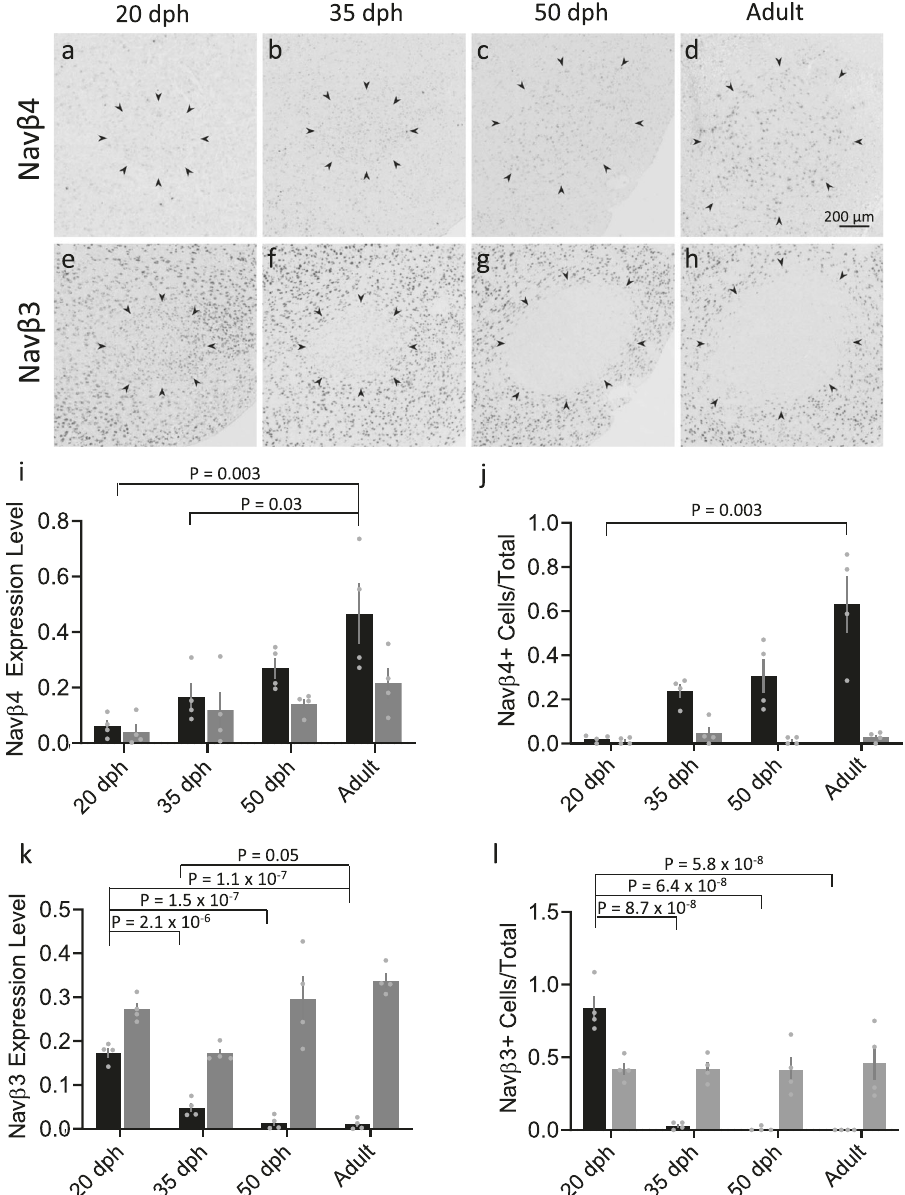
Fig. 3 Age-dependent changes in expression of Nav β 3 and Nav β 4 mRNAs in the arcopallium of male zebra fi nches. a – d Representative in situ hybridization images for Nav β 4 mRNA within RA across ages indicated by days post hatch (dph); black arrowheads indicate RA borders. e – h . Representative in situ hybridization images for Nav β 3 mRNA within RA across ages. Black arrowheads indicate RA borders. i Comparison of Nav β 4 expression levels (normalized optical density) across age groups within RA (black) and in a caudal arcopallial region of equal size outside RA (gray). Signi fi cant age differences were observed in RA (one-way ANOVA with Tukey ’ s post hoc; P = 0.005, F (3, 12) = 7.416, N = 4 males per age). Data are presented as individual data points with bars as mean values ± SEM. j Comparison of the proportions of Nav β 4-expressing cells across age groups within RA (black) and in an arcopallial region of equal size outside RA (gray). Signi fi cant age differences in RA (one-way ANOVA with Tukey ’ s post hoc; P = 0.001, F = F (3, 12) = 10.79, N = 4 males per group). Data are presented as individual data points with bars as mean values ± SEM. k Comparison of Nav β 3 expression level (normalized optical density) across age groups within RA (black) and in an arcopallial region of equal size outside RA (gray). Signi fi cant age differences in RA (one-way ANOVA with Tukey ’ s post hoc; P = 5.4× 10 − 8 , F (3, 12) = 73.43, N = 4 males per group). Data are presented as individual data points with bars as mean values ± SEM. l Comparison of the proportions of Nav β 3-expressing cells across age groups within RA (black) and in an arcopallial region of equal size outside RA (gray). Signi fi cant age differences in RA (two-way ANOVA with Tukey ’ s post hoc; P = 1.6×10 − 8 , F (3, 12) = 90.96, N = 4 males per group). Data are presented as individual data points with bars as mean values ± could be readily identi fi ed in sagittal brain sections obtained from dependent effects observed for both peak I NaR (Fig. 4c) and 20 to 50 dph male fi nches via infrared differential interference normalized peak I NaR / I NaT ratios (Fig. 4d). At the − 30 mV test microscopy (IR-DIC; Supplementary Fig. 5). Indeed, I NaR was pulse, signi fi cant differences were found for post hoc pairwise small or absent in RAPNs from 20 dph fi nches, but its magnitude comparisons of raw and normalized I NaR across all age groups. increased sharply with age (Fig. 4a, b), with signi fi cant age- Importantly, the average normalized peak I NaR / I NaT values were